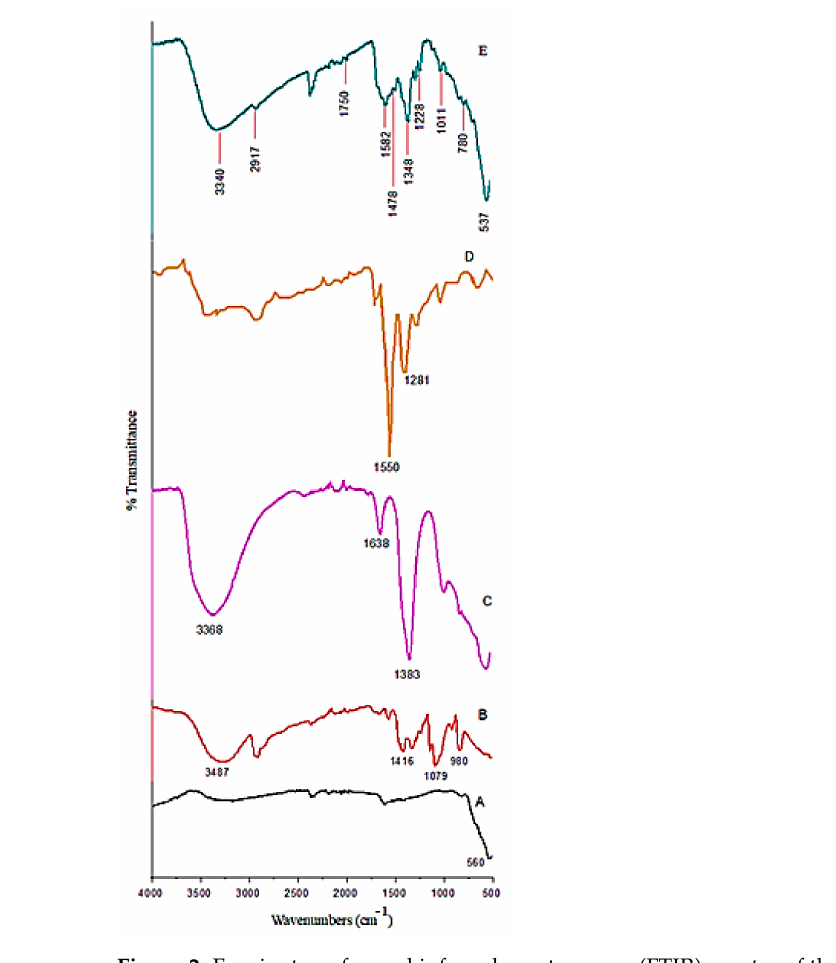
Figure 2. Fourier transformed infrared spectroscopy (FTIR) spectra of the pure Fe 3 O 4